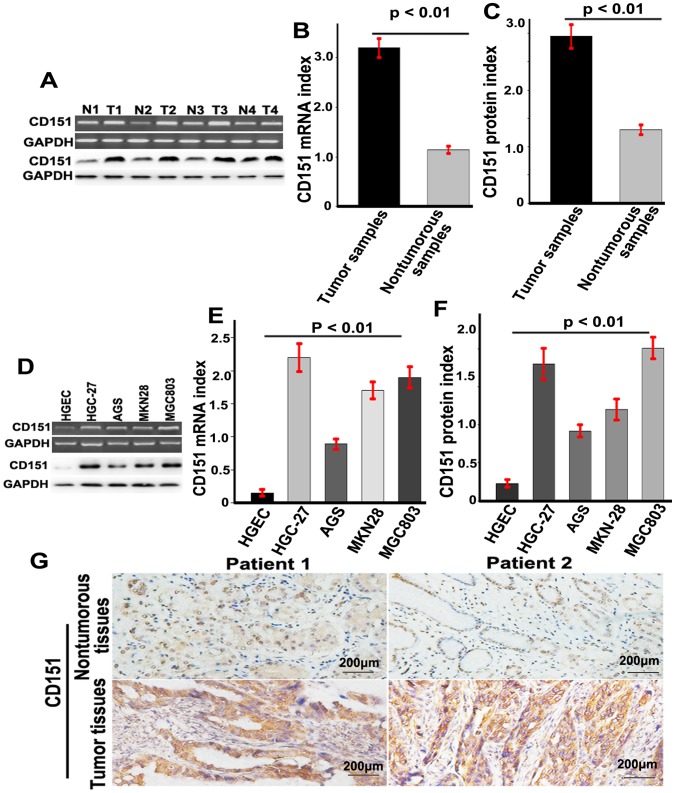
CD151 was overexpressed in HGC.(A) The expression of CD151 mRNA and protein in GC samples and the matched nontumorous samples; (B and C) a histogram showed CD151 mRNA in GC samples and the matched nontumorous samples (p<0.05); (D) RT-PCR and immunoblotting analyzed the expression of CD151 in HGEC and HGC-27, AGS, MKN28 and MGC803 cells (p<0.05); (E and F) A histogram showed CD151 mRNA and protein in HGEC and HGC-27, AGS, MKN28 and MGC803 cells (p<0.05).